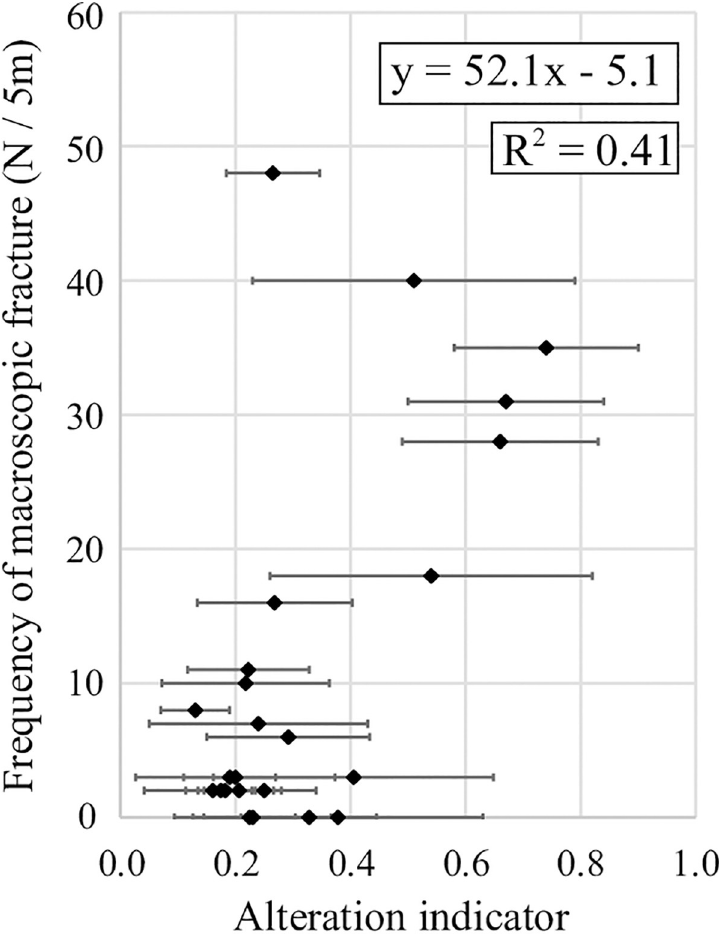
Fig 5. Relationship between the alteration indicators for rock samples and the macroscopic fracture